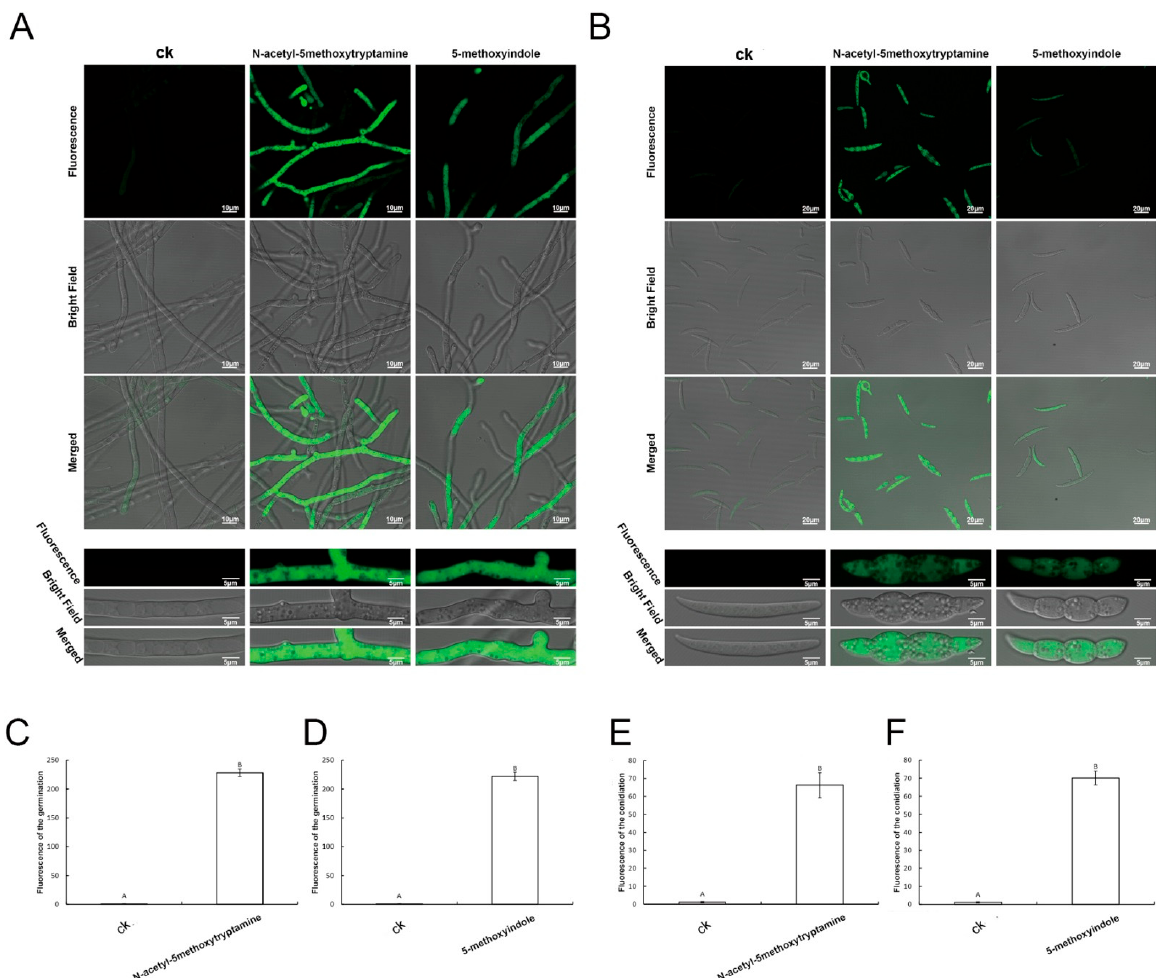
Figure 5. The ROS production of F. graminearum PH-1 hyphae and conidia after being treated with melatonin and 5-methoxyindole. ( A , B ) The ROS detection of F. graminearum hyphae and conidia were based on DCFH-DA staining after treatment with 4 mM melatonin and the 0.1 mM 5-methoxyindole grown for 3 days; ( C , D ) Average fluorescence analysis of F. graminearum hyphae after treatment with the melatonin and 5-methoxyindole grown for 3 days; ( E , F ) average fluorescence analysis of F. graminearum conidia after treatment with the melatonin and 5-methoxyindole grown for 3 days. The experiment was repeated independently three times, and 0.05% (vol/vol) methanol/water served as the ck. The error bars represent the mean standard deviation of each treatment repeated three times with three replicates. The letters above the columns indicate significant difference. The significant difference between the treatments was determined through Tukey’s HSD test at p ≤ 0.05. The higher level of green fluorescence indicates the high level of ROS induction in F. graminearum exposed to melatonin and